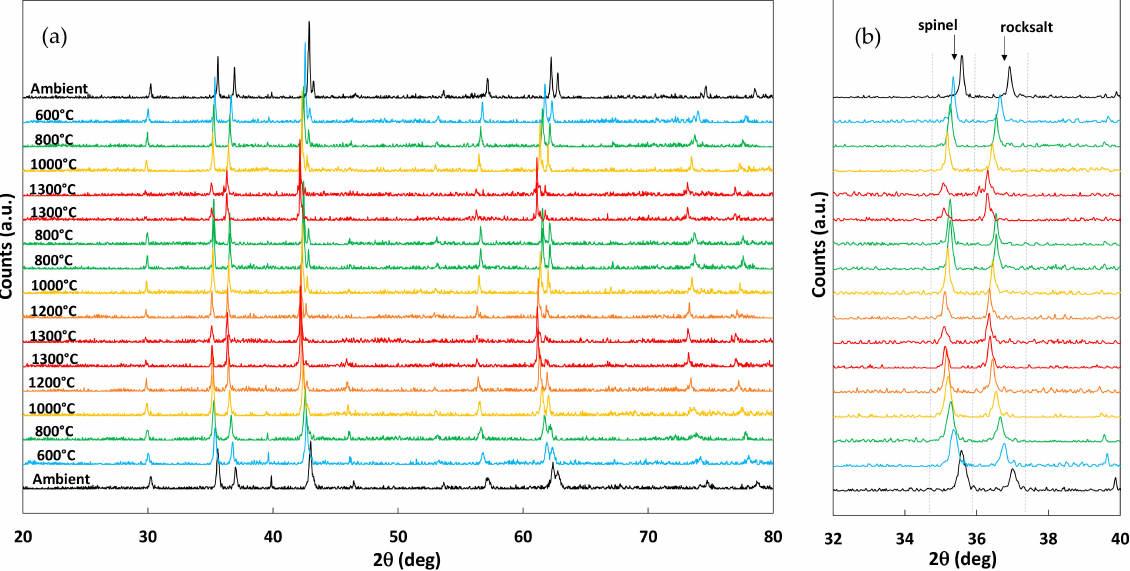
Figure 2. In situ XRD analysis of HEO 1 during two consecutive thermochemical cycles. ( a ) Full scale; and ( b ) Zoom from 2 θ = 32 ◦ –40 ◦